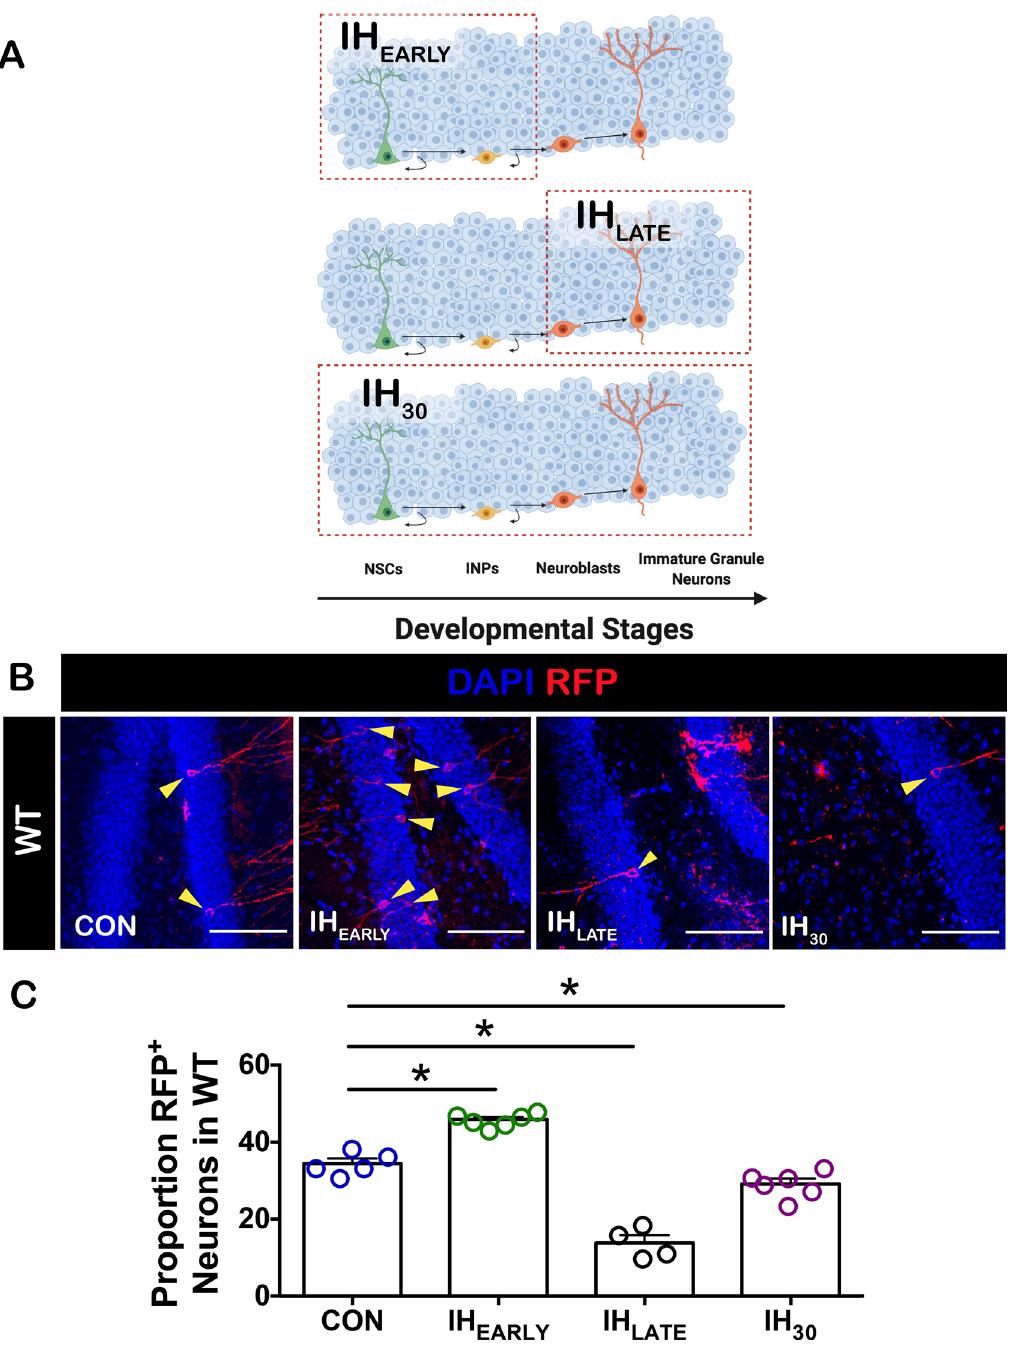
Figure 2. Stage-dependent effects of IH are revealed when neural precursors are exposed to IH 10 during different stages of adult neurogenesis. ( A ) A diagram illustrates the three different birth dating paradigms employed in this study: Labeled Nestin + NSCs experienced exposure to ten days of IH during the first critical period of neurogenesis followed by a recovery period of 20 days prior to sacrifice (IH EARLY ; Top), exposure to ten days of IH during the second critical period (IH LATE ; Middle), or exposure to IH for 30 days, encompassing both critical periods (IH 30 ; Bottom). Prior to any exposure to IH, all animals were injected with tamoxifen. The red outlines in each of the paradigms highlight the approximate developmental stages during which birth-dated cells were directly exposed to IH. ( B ) Representative images for RFP + neurons derived from wildtype (WT) birth- dated NSCs from CON, IH EARLY , IH LATE , and IH 30 conditions were examined. Yellow triangles identify RFP + neurons. Scale bars are 100um. ( C ) Differences were observed between the proportion of RFP + neurons derived from WT NSCs in all conditions (CON: n = 5, IH EARLY : n = 6, IH LATE : n = 4, IH 30 : n = 6). One way ANOVA with Dunnet’s multiple comparisons: P = < 0.0001, F = 91.05. CON vs. IH EARLY : P < 0.0001, CI of diff = -16.21 to -6.664. CON vs. IH LATE : P < 0.001, CI of diff = 15.34 to 25.92. CON vs. IH 30 : P < 0.05, CI of diff = 0.5268 to